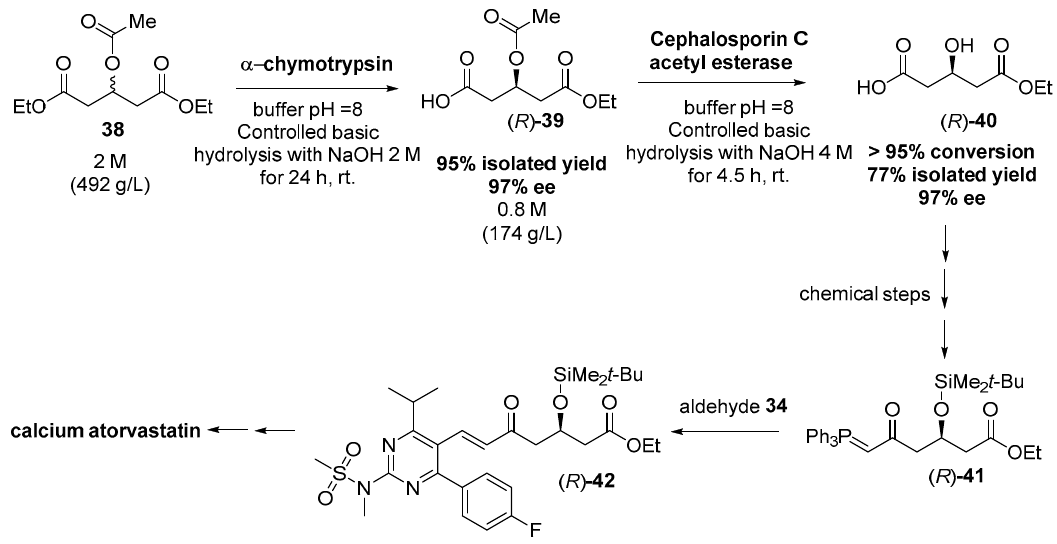
Figure 9. Two-enzymatic system for synthesizing chiral intermediates for Rosuvastatin, as described by Metzner et al. [189].